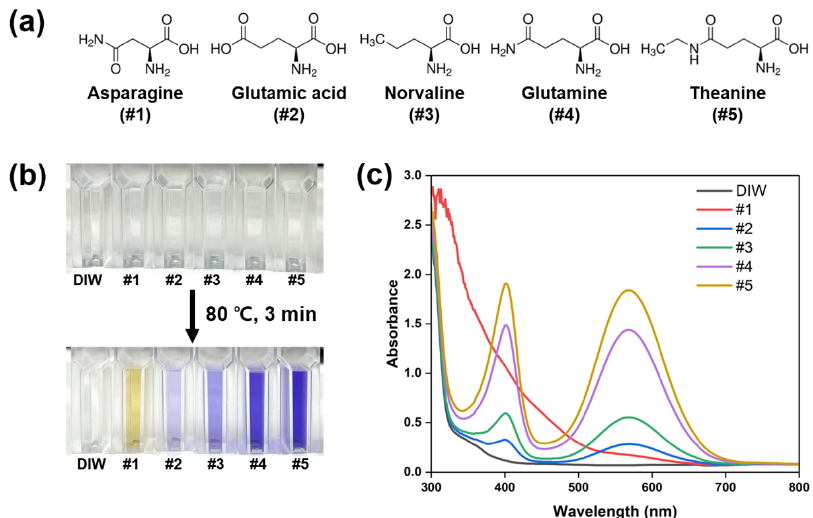
Figure 2. ( a ) Molecular structures of five natural free amino acids (asparagine, glutamic acid, norvaline, glutamine, theanine). ( b ) The photograph of color change in the amino acid aqueous solution in the ninhydrin solution-based assay. ( c ) UV-Visible absorption spectra of the amino acid aqueous solution by the ninhydrin assay.